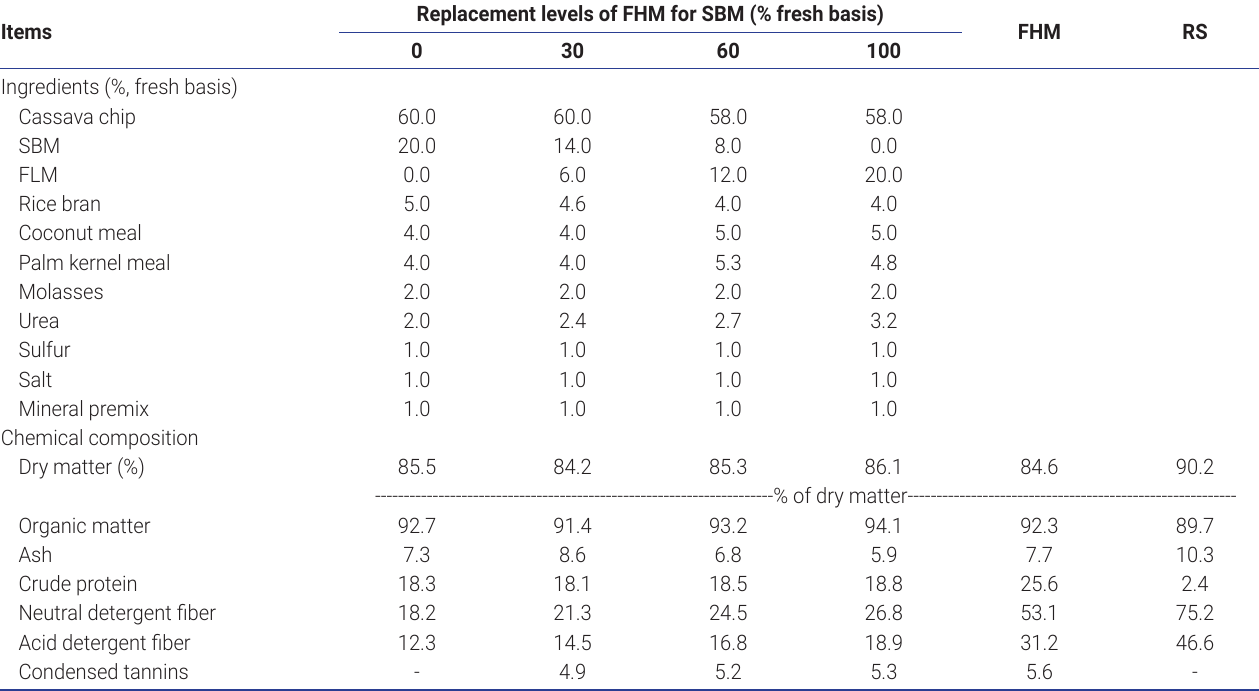
Table 1. Feed ingredients, concentrate mixtures and chemical